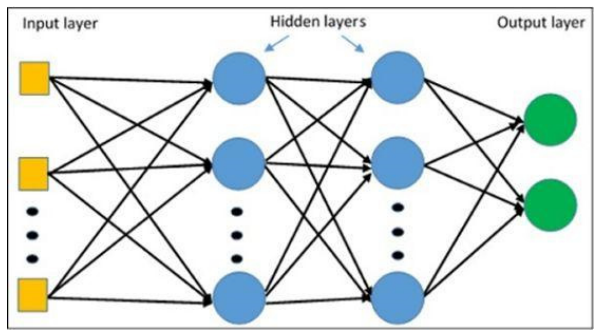
Figure 1. Classic neural